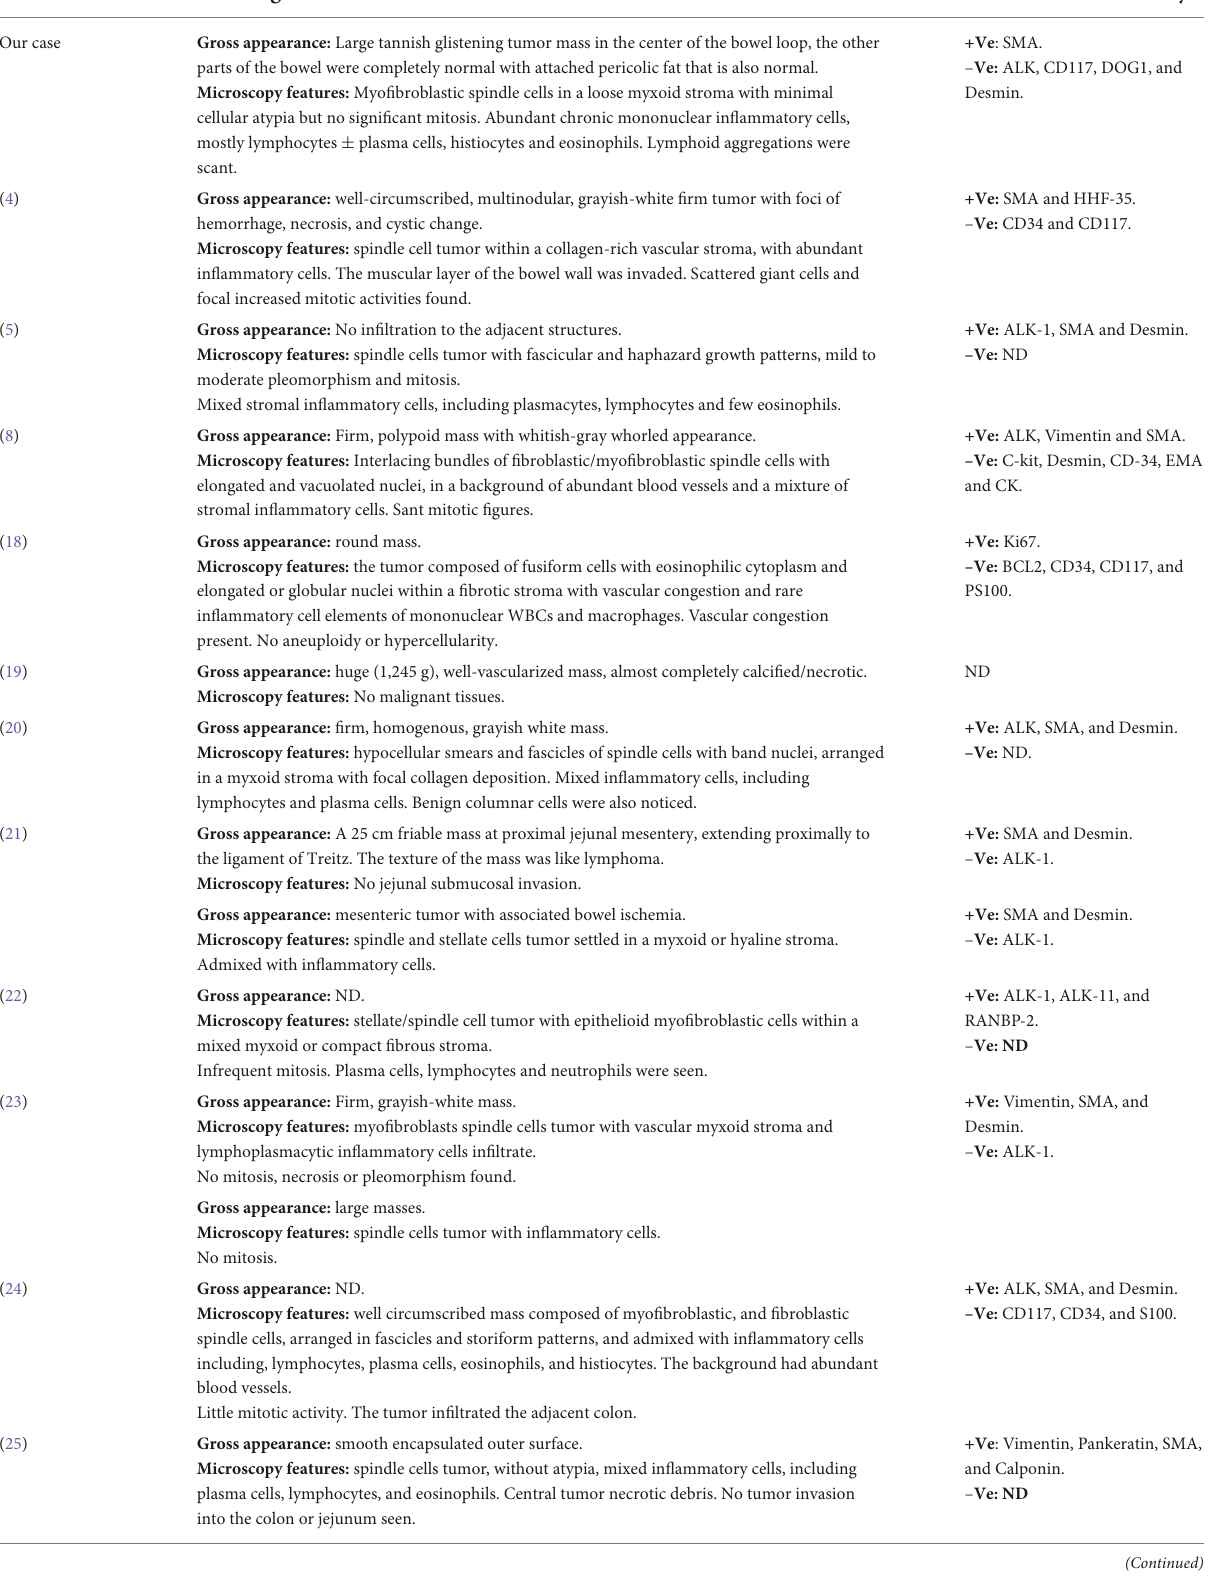
TABLE 3 Pathological features of the reported cases of inflammatory myofibroblastic tumor of the